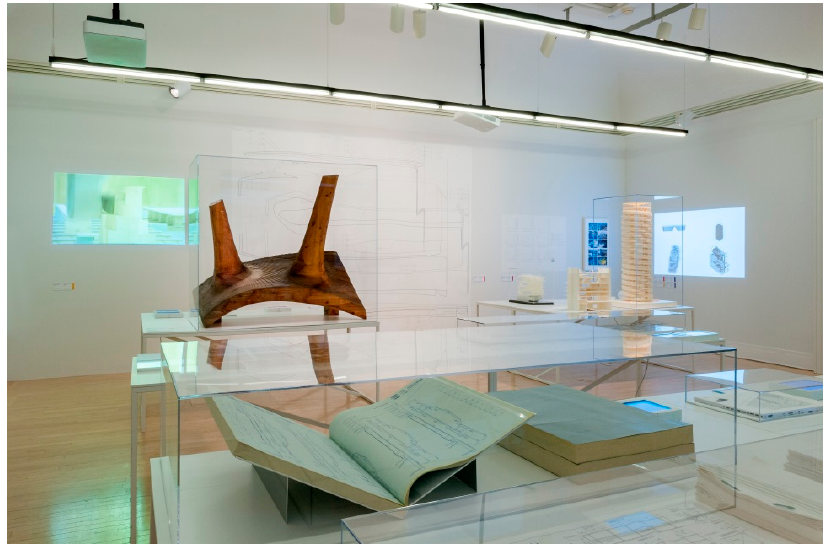
Figure 6. Archaeology of the Digital: Complexity and Convention, installation view with the drawings for FoA’s Yokohama terminal in the front, Canadian Centre for Architecture, 2016. Photograph: © CCA.